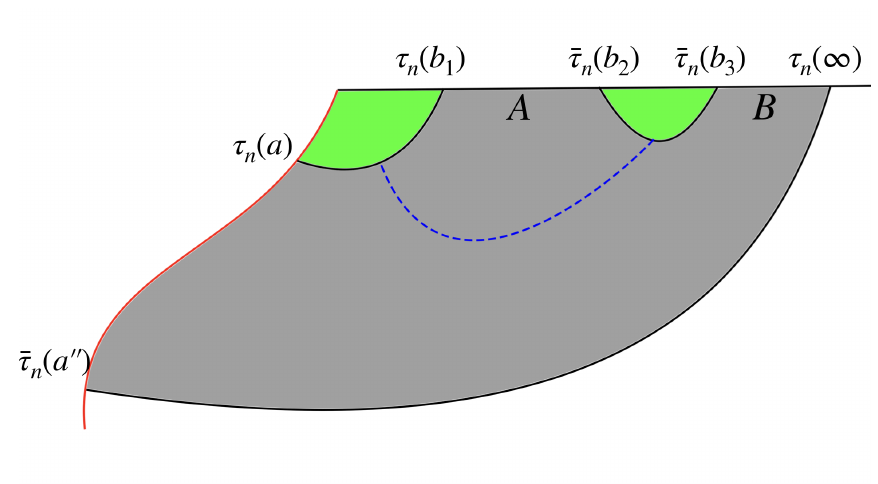
Figure 7: Schematic for the island proposal-II for the entanglement negativity for the mixed state configuration of the disjoint intervals in phase-II. Figure modified from [ 68 ]